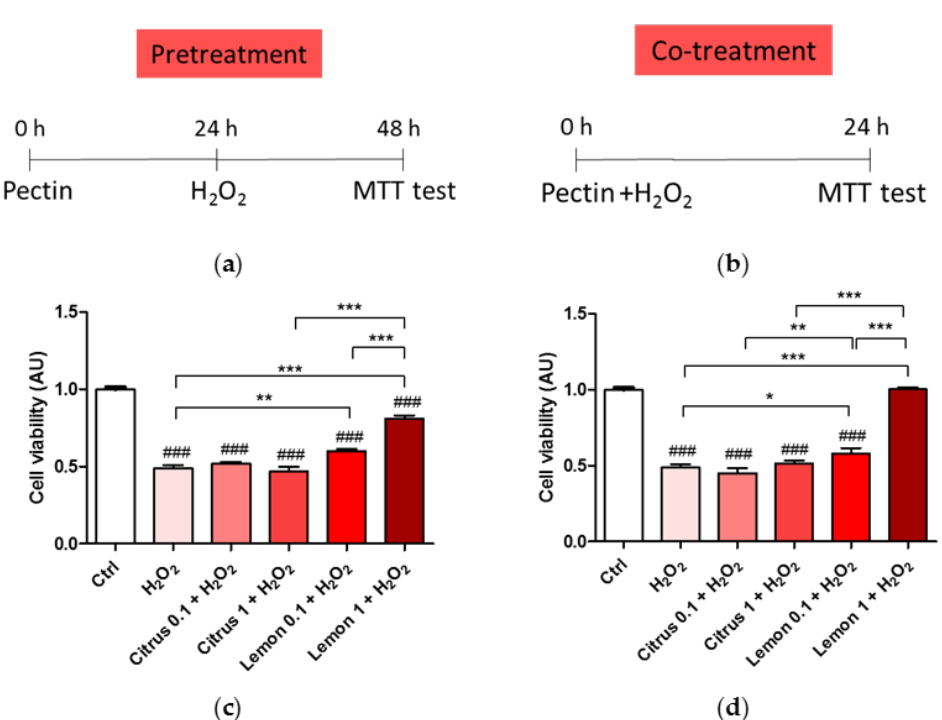
Figure 2. Oxidative insult during pretreatment and co-treatment with commercial (citrus) and lemon IntegroPectin (lemon) pectins: ( a ) Scheme of cell pretreatment with pectins; ( b ) Scheme of cell co-treatment with pectins; ( c ) Cell viability of pretreatment in dose dependent experiment; ( d ) Cell viability of co-treatment in dose dependent experiment. Tukey test: ### p < 0.001 as compared to control (Ctrl) group; * p < 0.05, ** p < 0.01, *** p < 0.001.